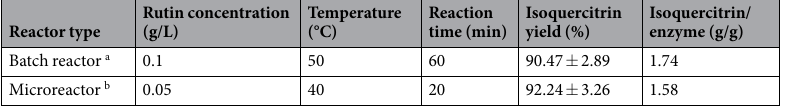
Table 3. Comparative results for the enzymatic-catalyzed transformation of rutin to produce isoquercitrin in different reactors. a: Reaction condition: rutin concentration 0.1 g/L, reaction temperature 50 °C, 120 r/min in an incubator shaker, reaction time 1 h, graphene immobilized naringinase was suspended in a reaction system; b: Reaction condition: rutin concentration 0.05 g/L, reaction temperature 40 °C, flow rate 4 μ L/min, reaction